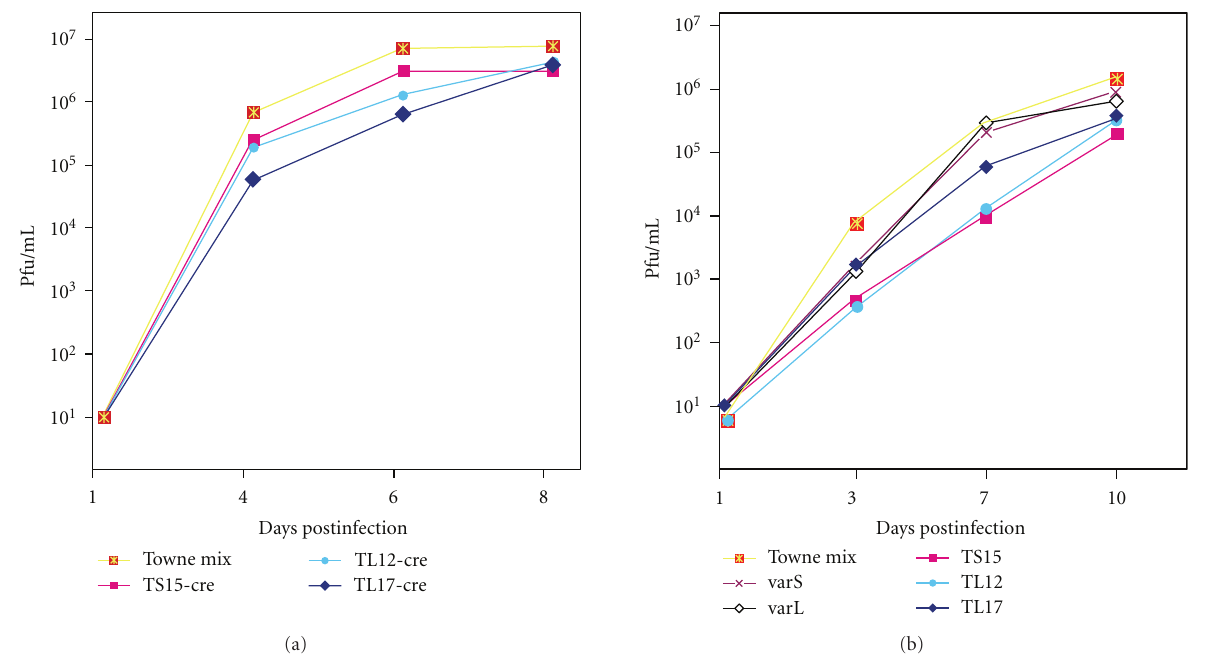
Figure 3: Growth curves of BAC-derived viruses and viruses derived from the vaccine. MRC-5 cultures were infected at MOIs of 0.1 (left) and 0.05 (right) with the vaccine virus mixture (Towne mix), varS, or varL viruses isolated from the vaccine and BAC-derived viruses lacking (-cre) or containing the BAC ori . Titers of each virus in the culture supernatants were determined on the days indicated.